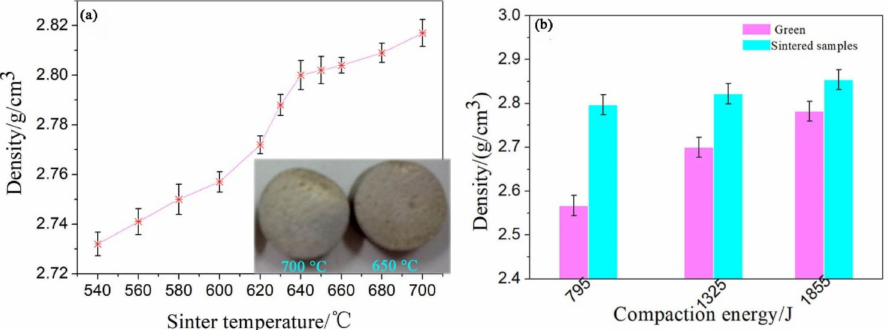
Figure 1. ( a ) Sintered density versus sintering temperature: all specimens were compacted with compaction energy of 1325 J and sintered for 60 min at temperature; ( b ) Sintered density versus compaction energy.